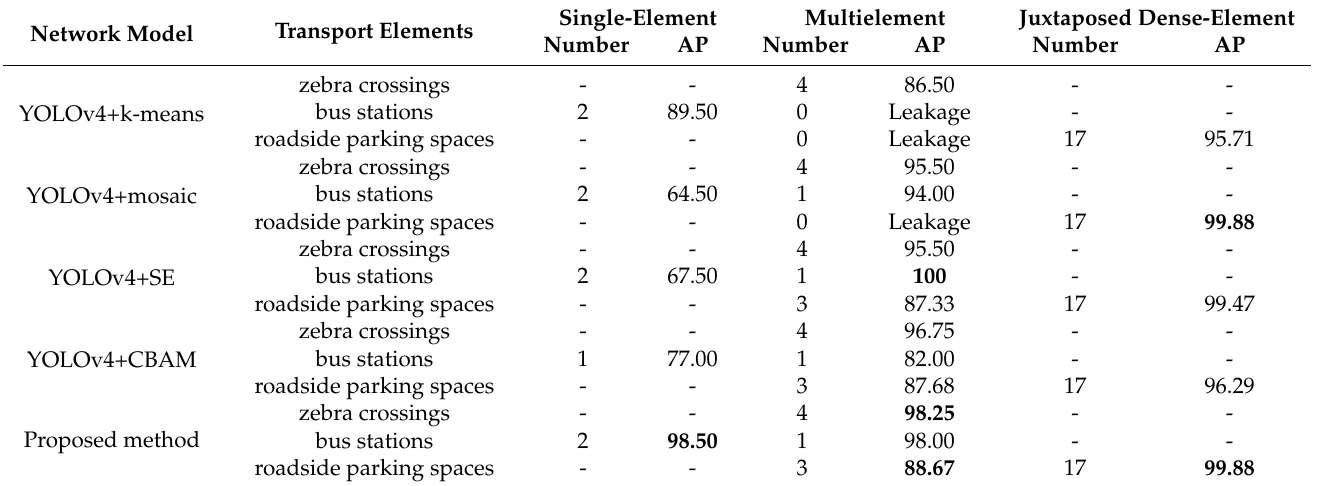
Table 4. Predicted results of ablation experiments in small scenarios.